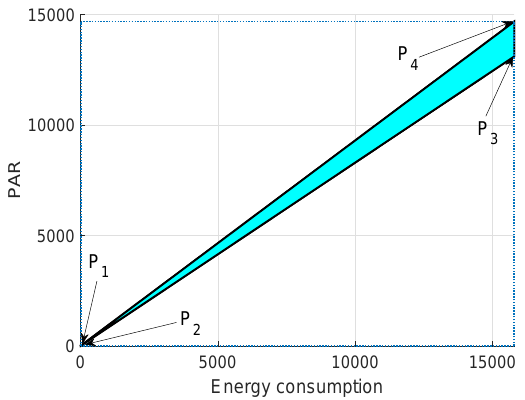
Figure 16. Feasible region for energy consumption and PAR using